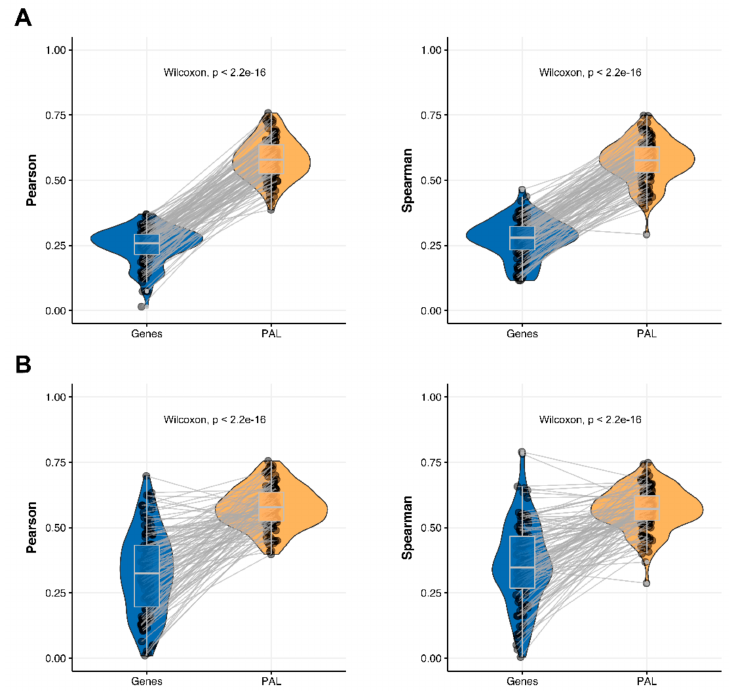
Figure 7. Paired gene-to-gene and PAL-to-PAL correlation between RNA and protein expression levels estimated within Lung Adenocarcinoma biosamples using Pearson ( left ) and Spearman ( right ) correlation coefficients for ( A ) the total set of genes and molecular pathways; ( B ) the set of drug target genes and molecular pathways [17].